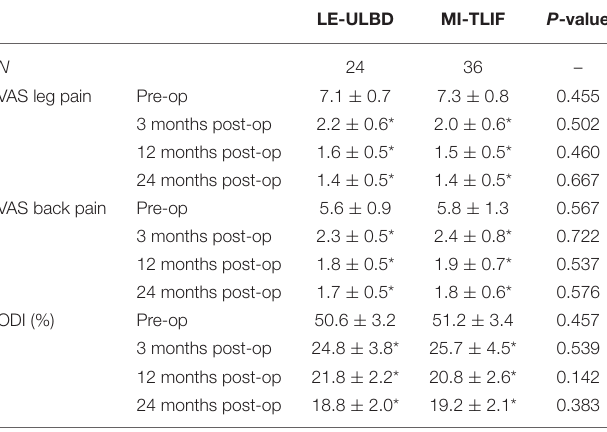
TABLE 4 | Comparison of VAS and ODI scores in the two groups.